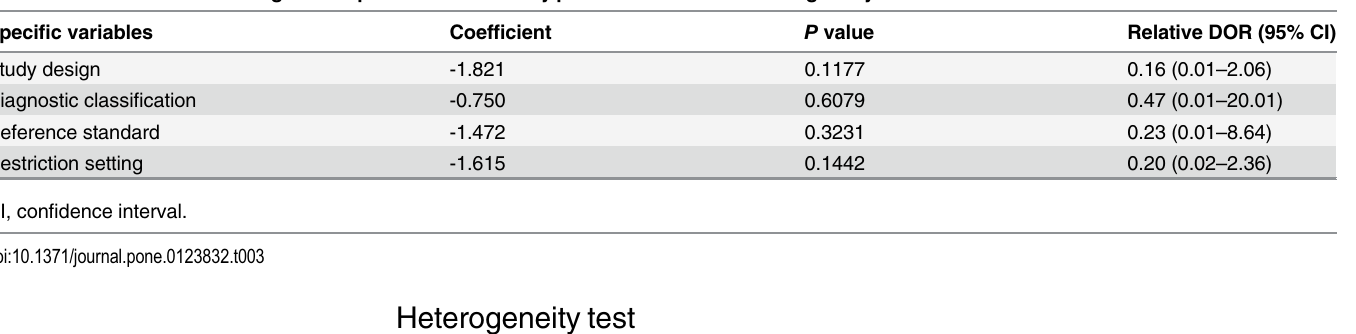
Table 3. Results of the meta-regression performed to identify potential sources of